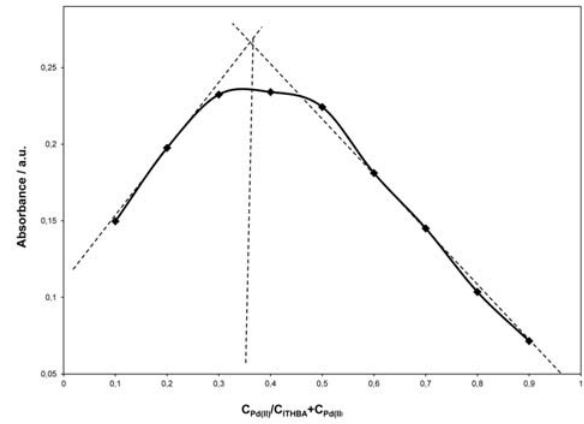
Fig. 5. The method of continuous